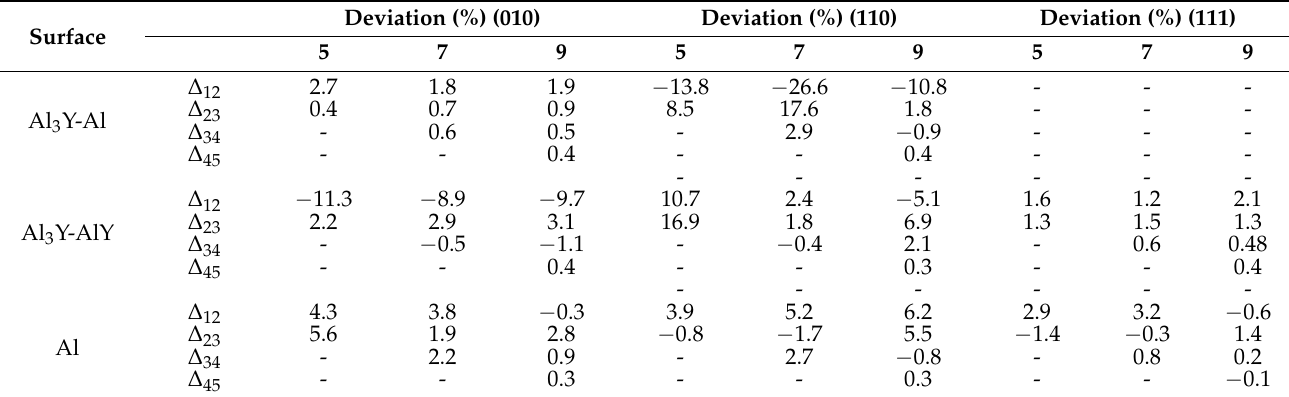
Table 3. Deviation of the layer distances after optimization.